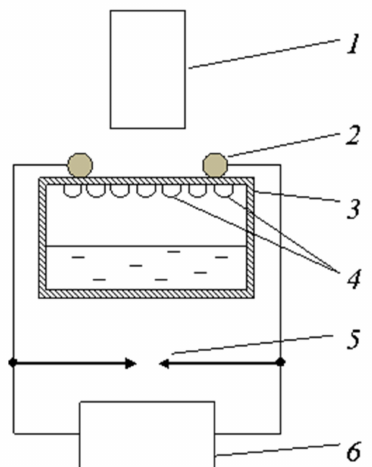
Figure 2. Block diagram of the installation. 1—camera, 2—cylindrical electrode, 3—plastic container with water, 4—drops of water, 5—discharger, and 6—electrostatic